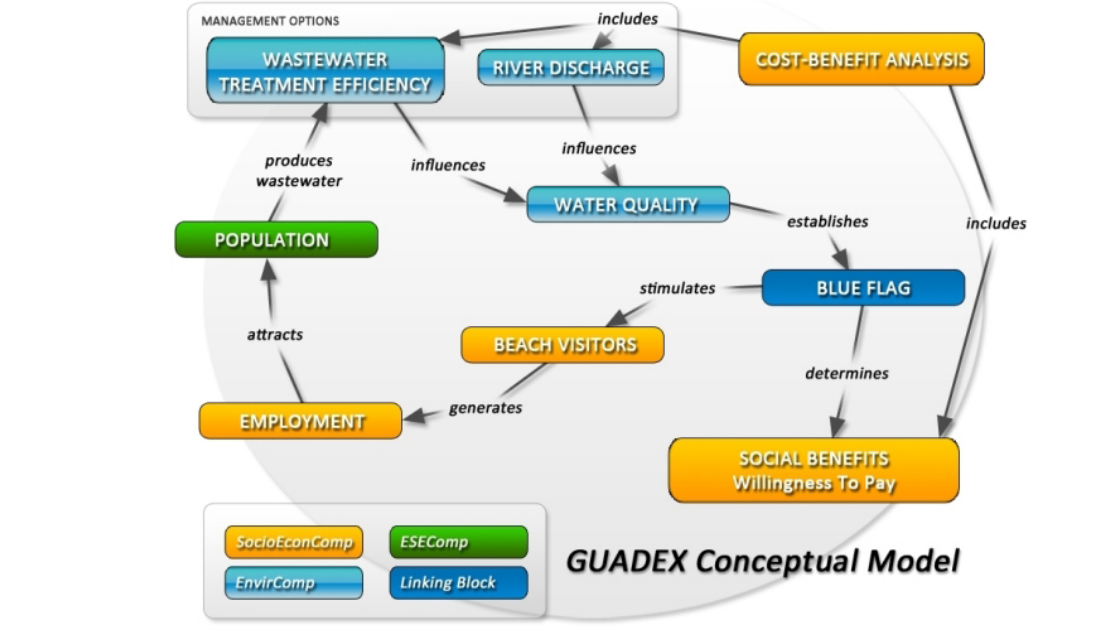
Fig. 2 . Conceptual model of Guadiana Estuary System used for designing the simulation analysis of the Policy Issue. The box colors represent the modeled components: environmental (light blue), socioeconomic (yellow), ecological-social-economic (ESE) (green) and linking block (blue). Population block is an input to the environmental component and at the same time it’s an output of the socioeconomic component, hence it is highlighted. The Blue Flag block makes the simulation model operational by linking the ecological output to the socioeconomic model.